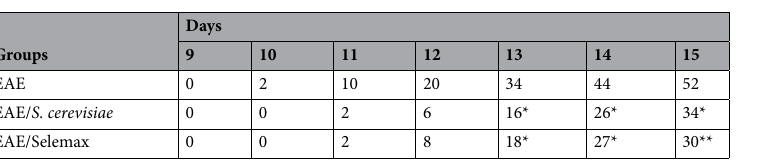
Table 1. Cumulative EAE score. Clinical scores were assessed every day during 15 days after EAE induction. The cumulative EAE score was obtained by the sum of daily scores from each mouse in EAE (n = 16), EAE/ S. cerevisiae (n = 18) and EAE/Selemax (n = 21) groups. Four independent experiments were combined. Two-way ANOVA and subsequent Tukey’s test, * p < 0.05 and ** p < 0.01 in comparison to EAE group.